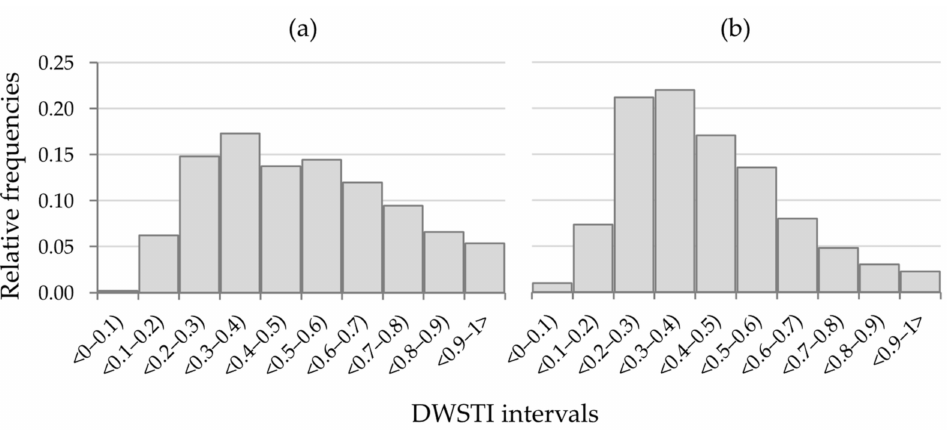
Figure 8. Comparison of relative frequencies DWSTI according to population size of municipalities: